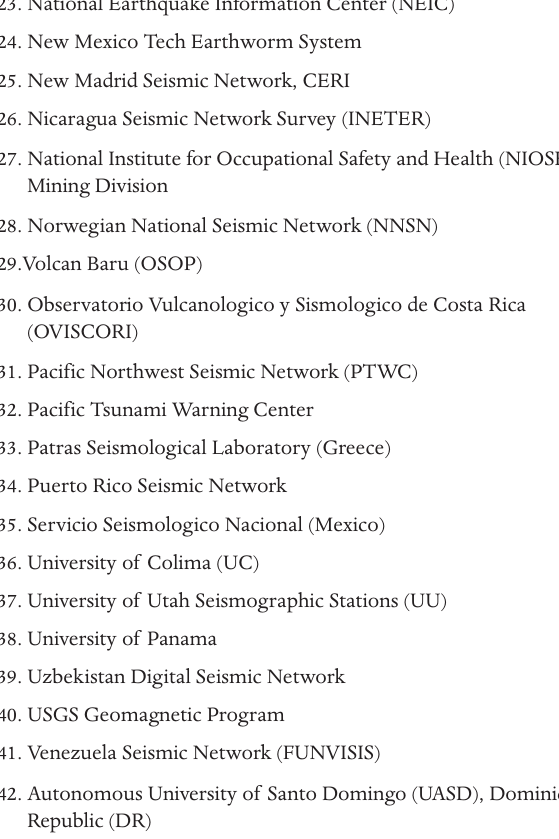
Table 1. EartWorm installations around the World